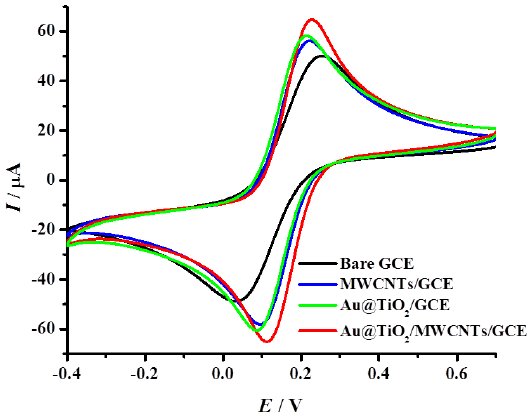
Figure 8. Cyclic voltammetric responses for bare GCE, MWCNTs/GCE, Au@TiO 2 /GCE and